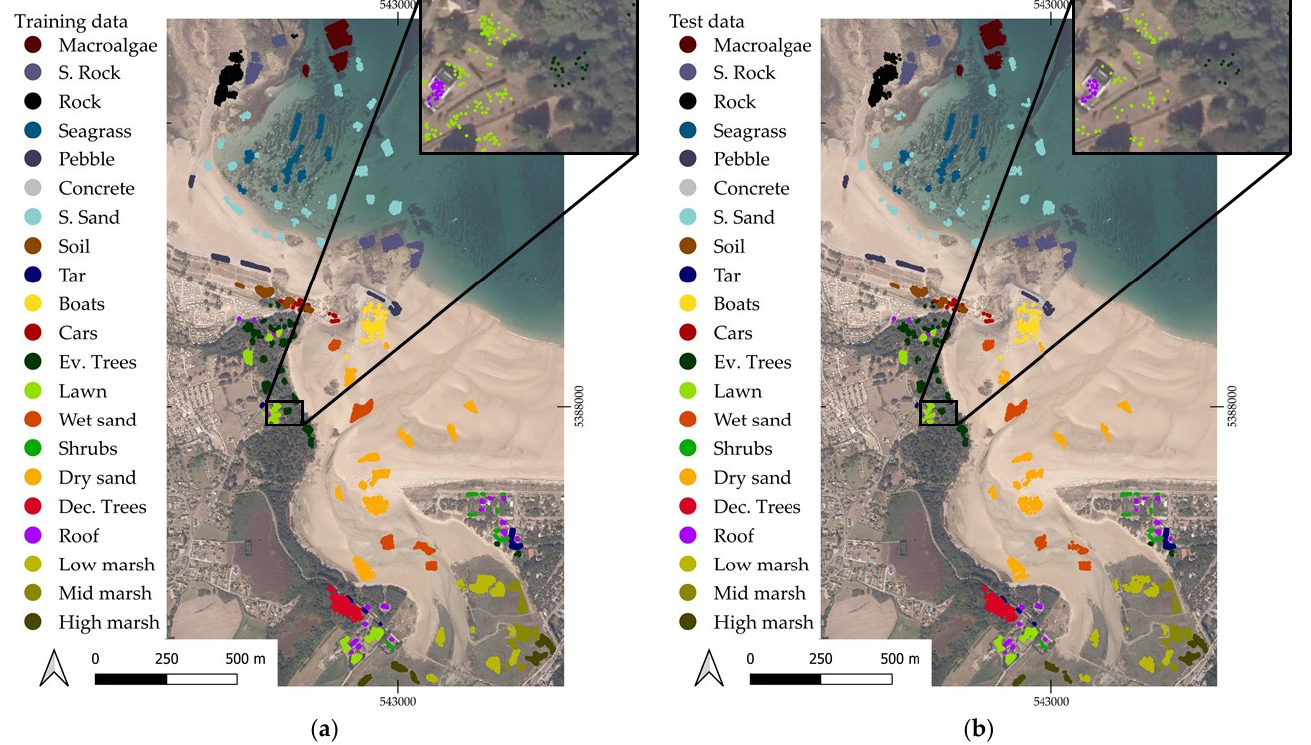
Figure 4. Repartition of the training and test data over the study area (datum: WGS 84; projection: UTM 30N). ( a ) Training data distribution; ( b ) test data distribution. S. = submerged, Ev. = evergreen, Dec. = deciduous. The size of the points in the illustration may give a false impression of overlapping, but all points have distinct locations.